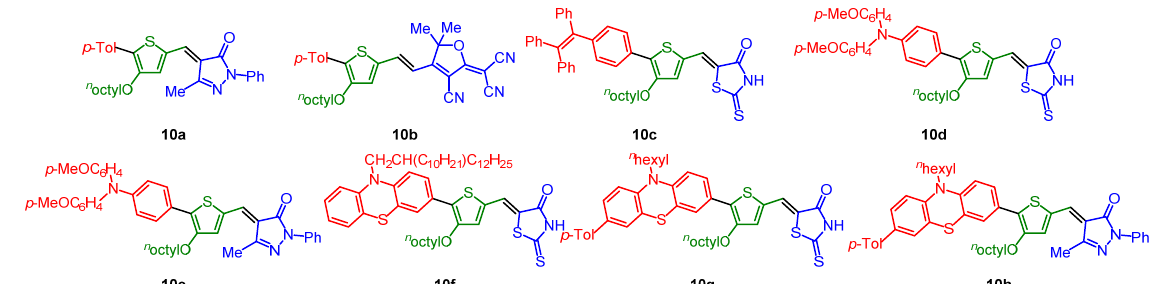
Table 1. Selected electronic properties of Merocyanines 8 – 12 (recorded in CH 2 Cl 2 , T = 298 K). Compound E 1/2 vs.